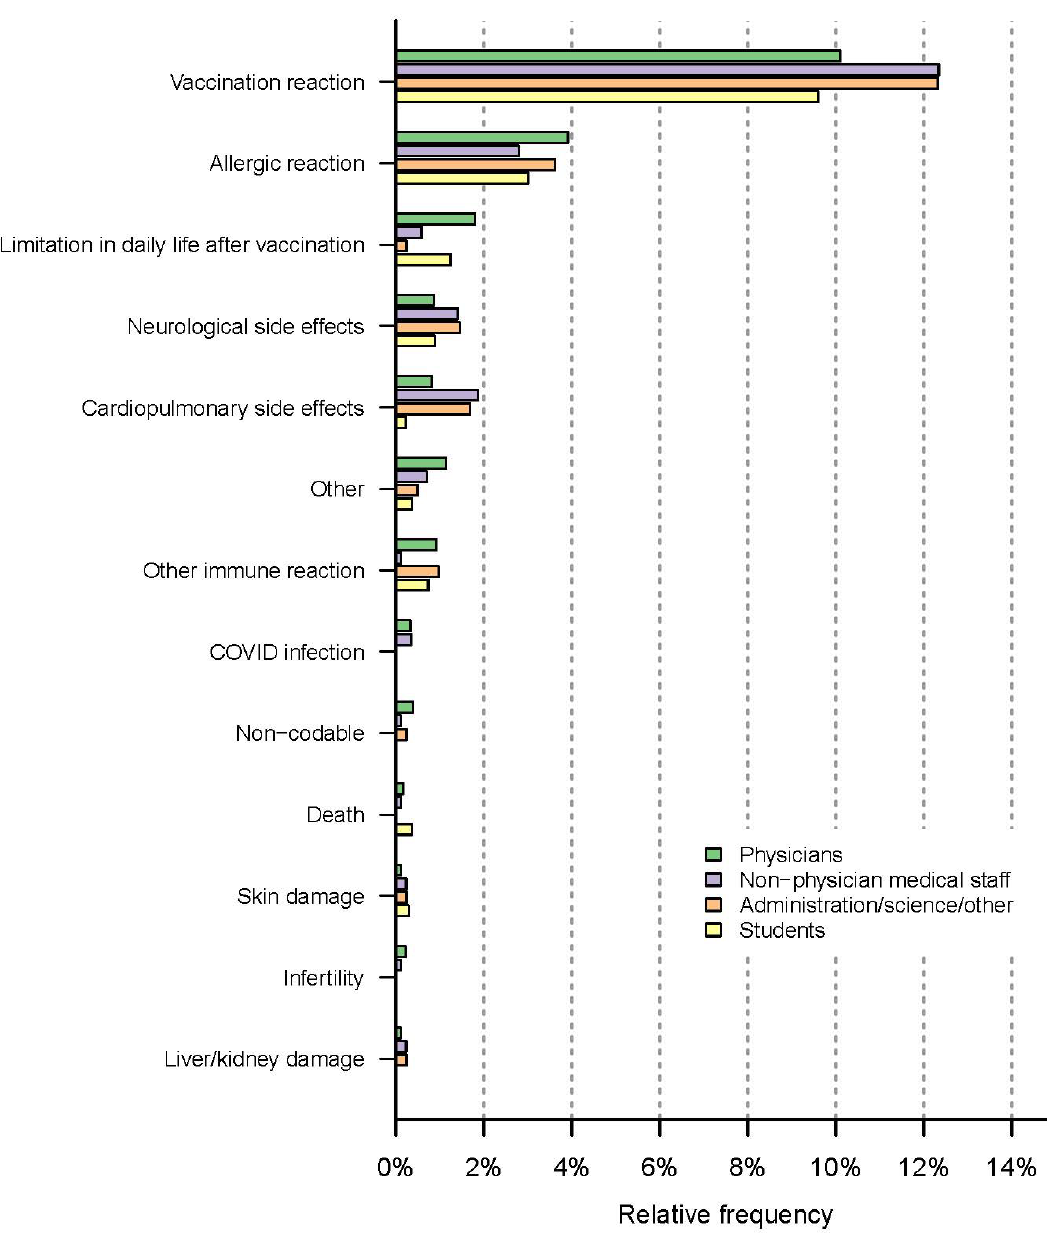
Figure 8. Professional groups and feared short-term side effects.